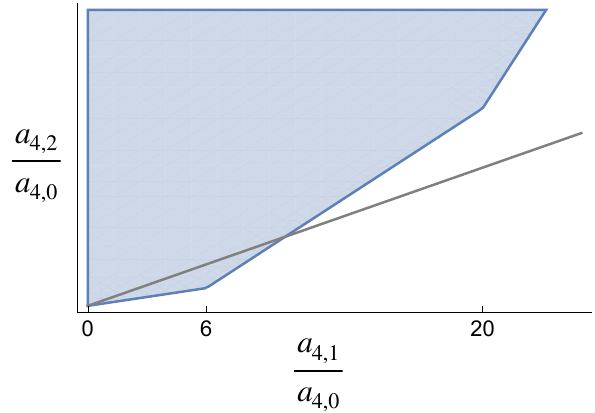
Figure 8 . ( a 4 , 1 , a 4 , 2 ) polytope and a 4 , 2 = 8 a 4 , 1 symmetry